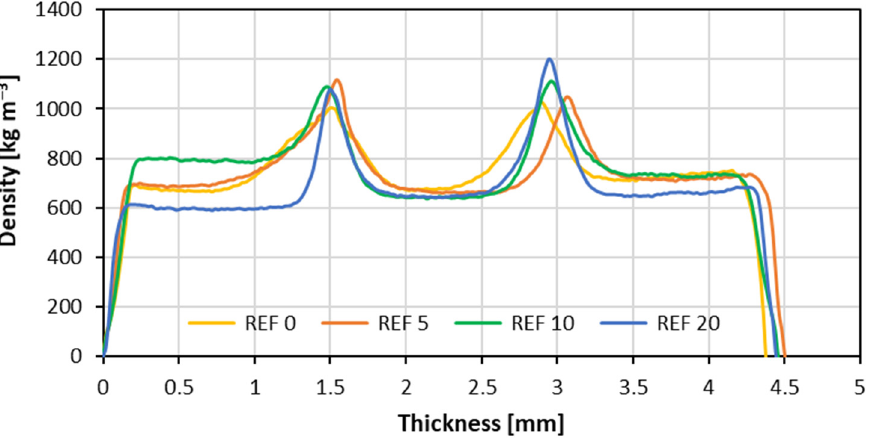
Figure 8. The density profiles of the reference plywood samples of different filler content.